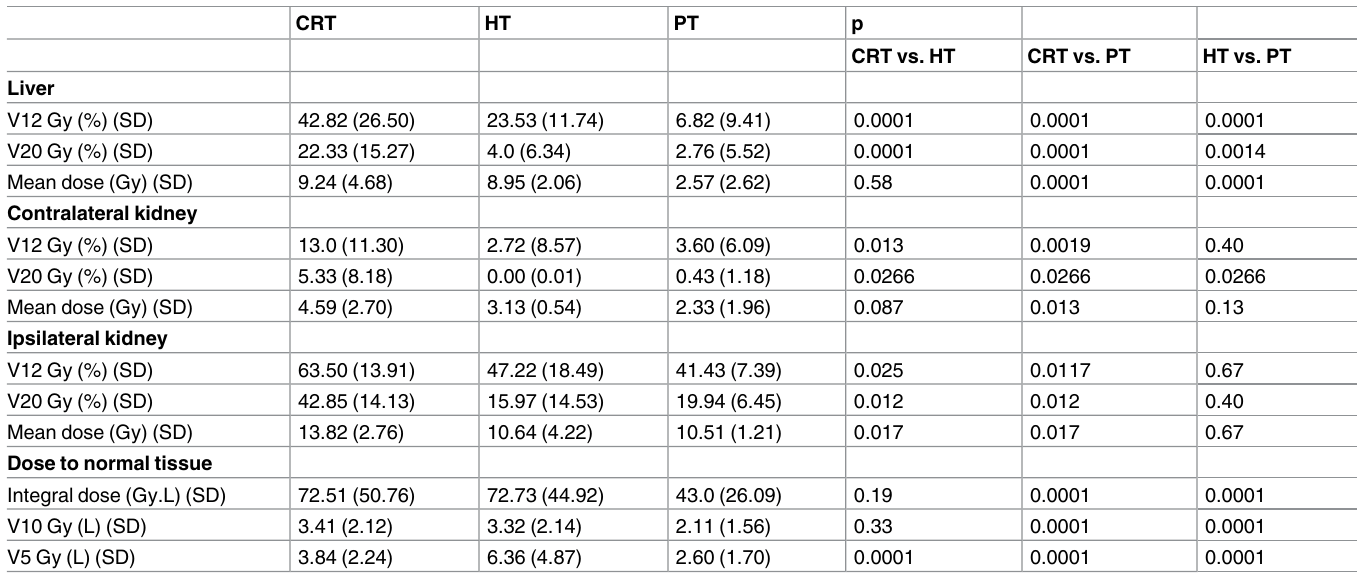
Table 3. Dose to OARs and normal